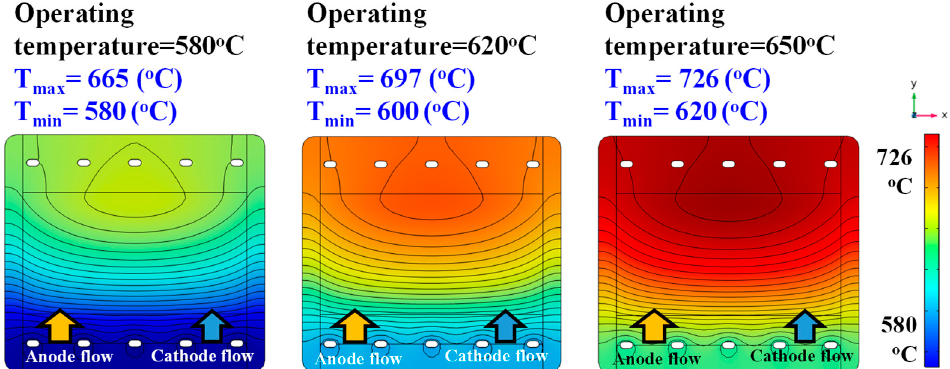
Figure 11. Temperature distribution according to the operating temperature.